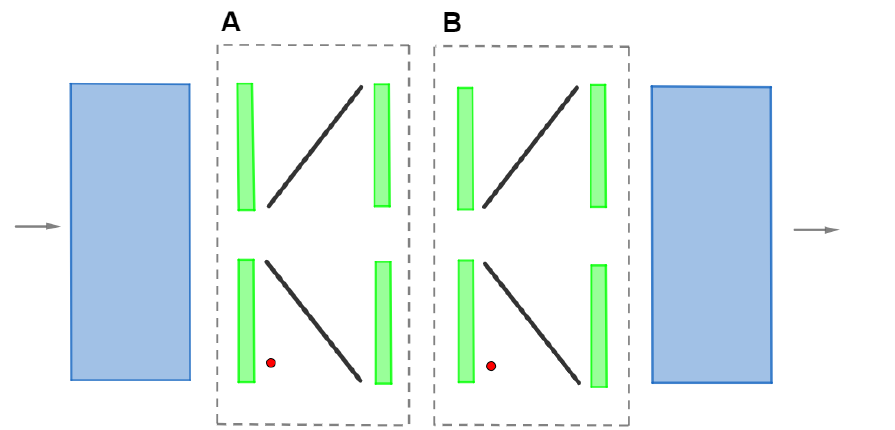
Figure 1. HS-WIM configuration comprised of 2 independent weighing grids, A and